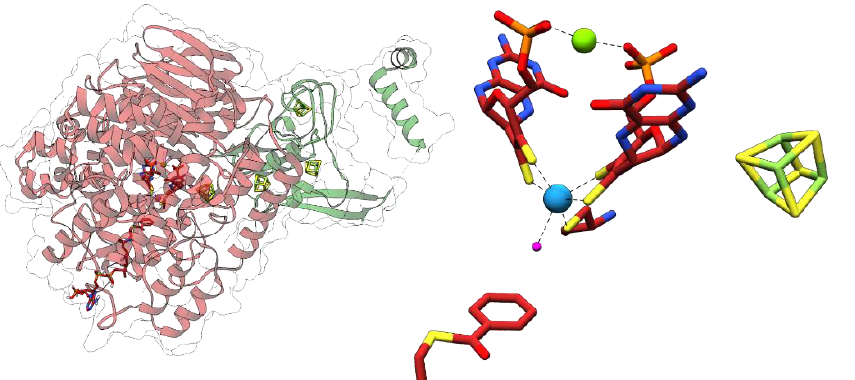
Figure 6. Structure of the BamBC components of class II benzoyl-CoA reductase from G. metallireducens (pdb 4Z3W-Z). Left panel: overall structure; the catalytic BamB subunit depicted in red contains the W-bis-MPT cofactor, BamC (light green) contains 3 [4Fe-4S] clusters. Right panel: W-bis-MPT, [4Fe-4S] cluster and the substrate benzoyl-CoA. Tungsten (blue) is coordinated by five thiols (four from the dithiolenes and one from Cys322), and by an inorganic ligand (magenta). A Mg 2+ bridging the phosphate groups of the two MPTs is shown in green.